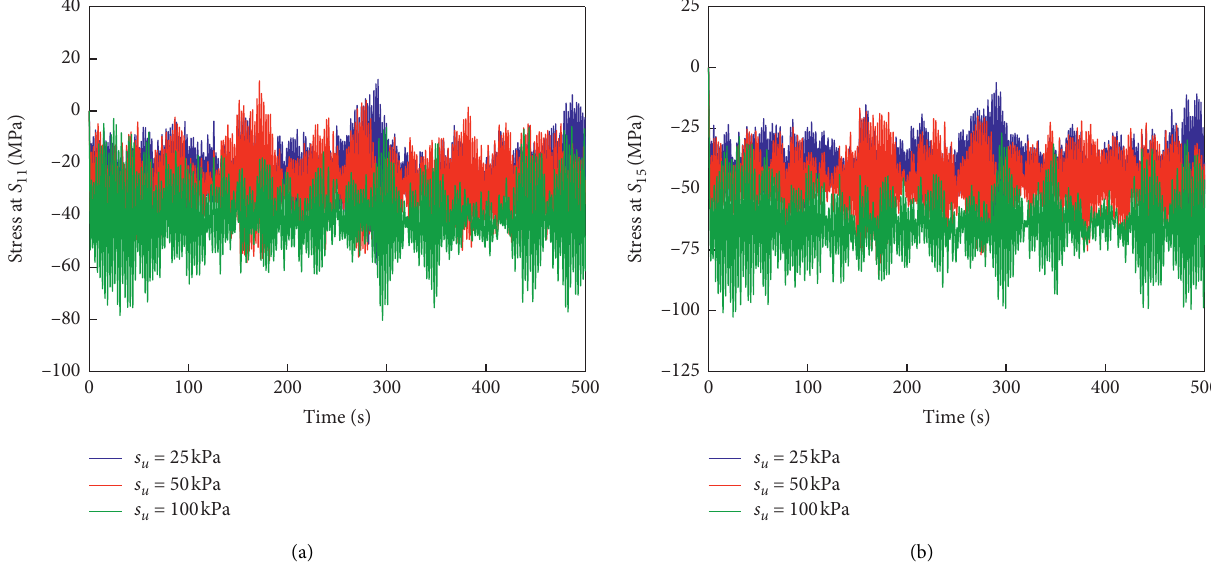
11 ; (b) time histories of